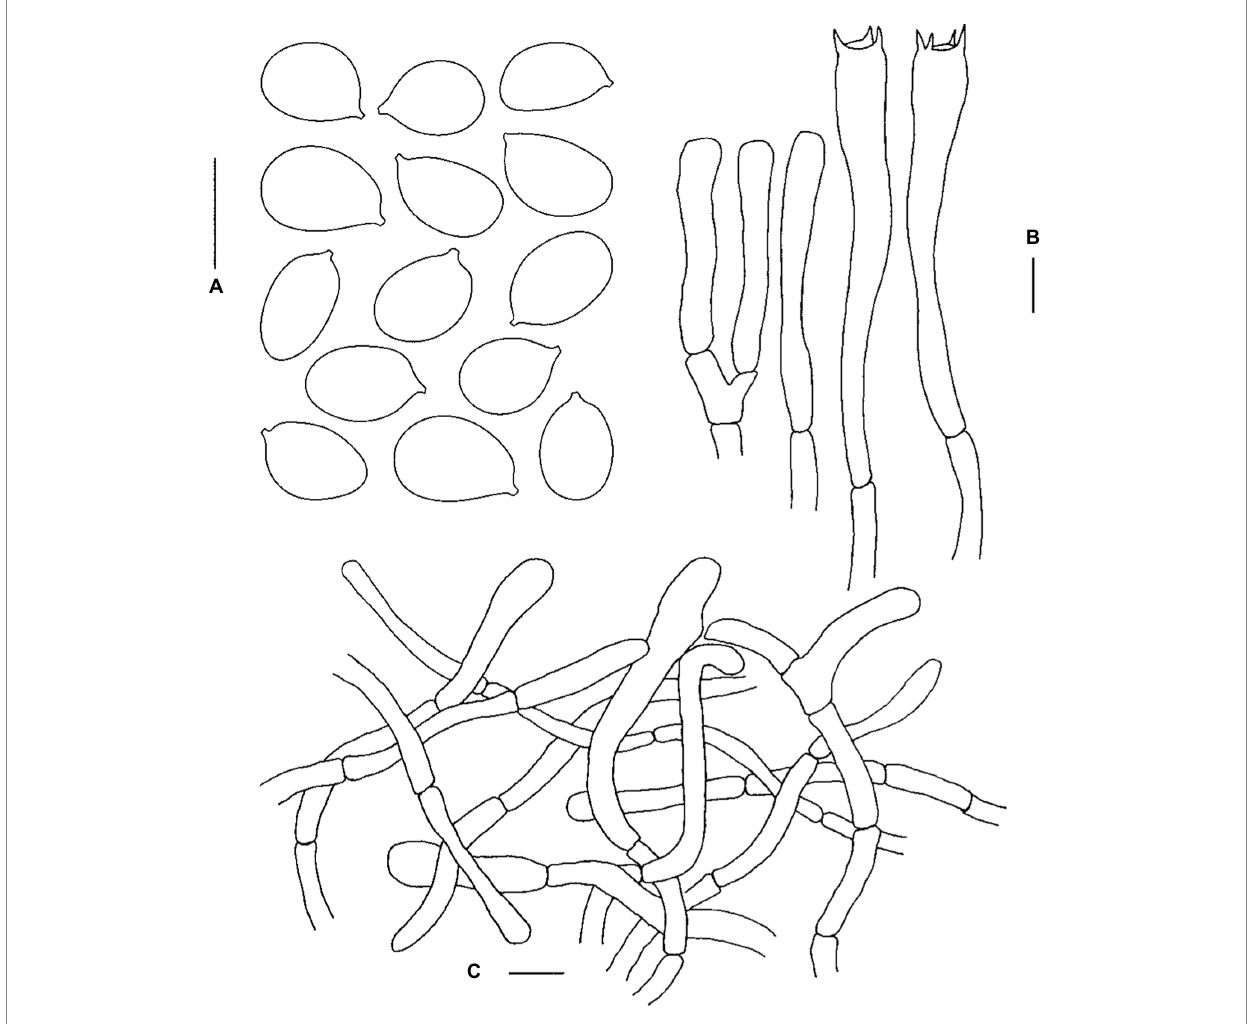
FIGURE 5 Microscopic features of Cantharellus hygrophoroides (FHMU1635). (A) Basidiospores. (B) Basidia. (C) Pileipellis. Scale bars = 10 μ m. Drawings by Y. Z.